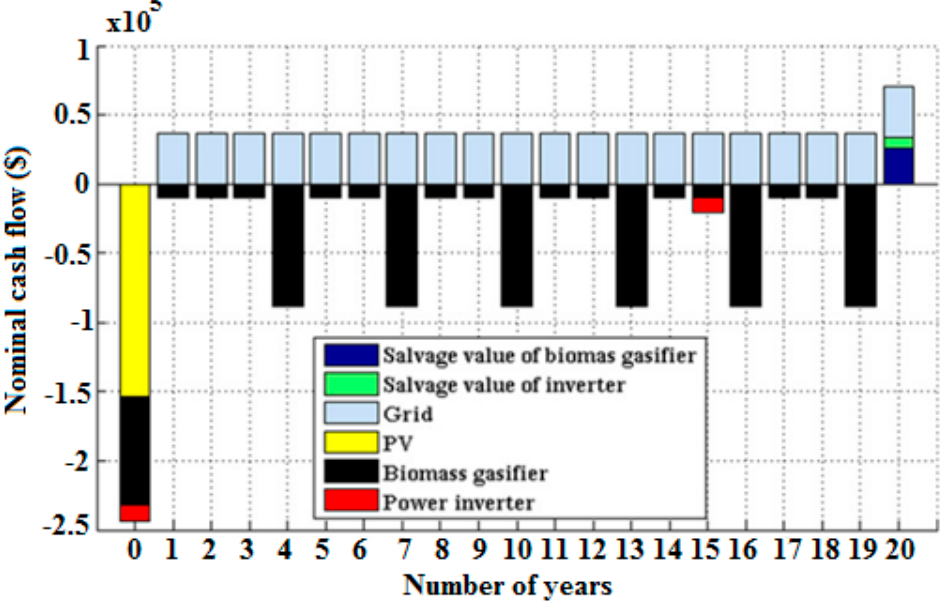
Figure 9. Nominal cash flow of the system.